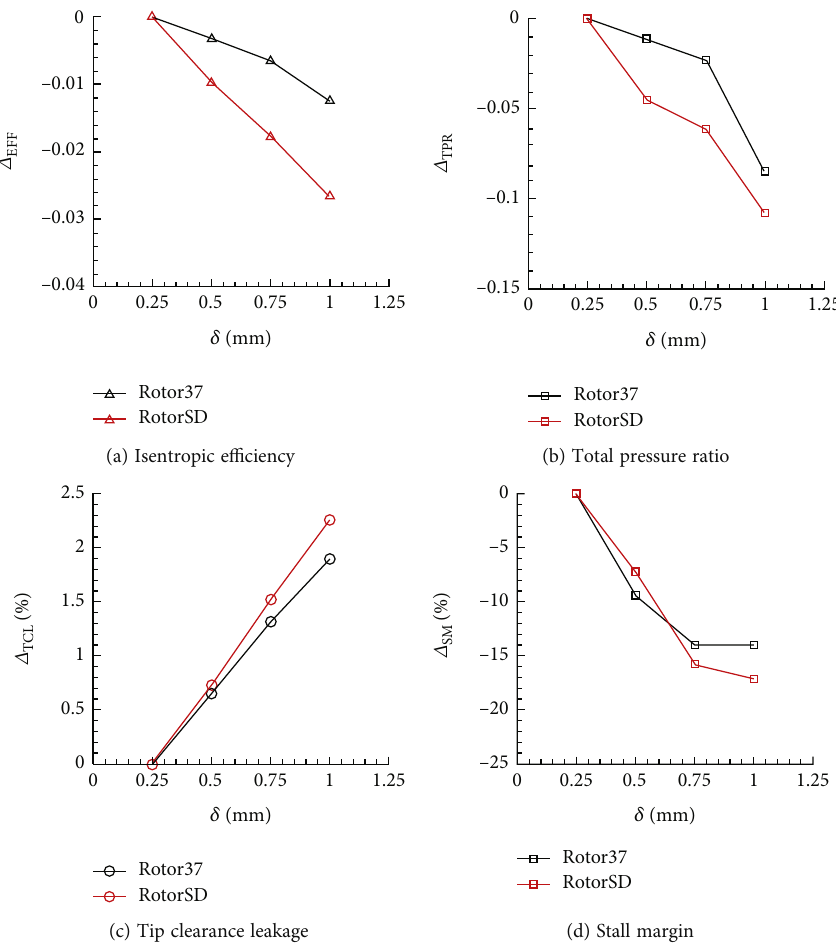
Figure 9: Comparison of the e ff ect of the tip clearance on the performance of the two rotors.